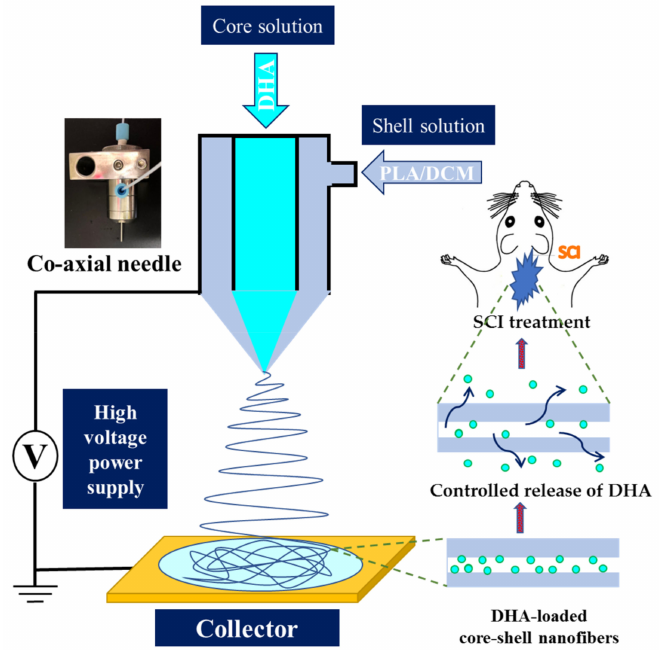
Figure 1. The schematic diagram showing the preparation of docosahexaenoic acid (DHA)-loaded core-shell nanofibers using polylactic acid / dichloromethane (PLA / DCM) shell solution for the treatment of spinal cord injury (SCI) in